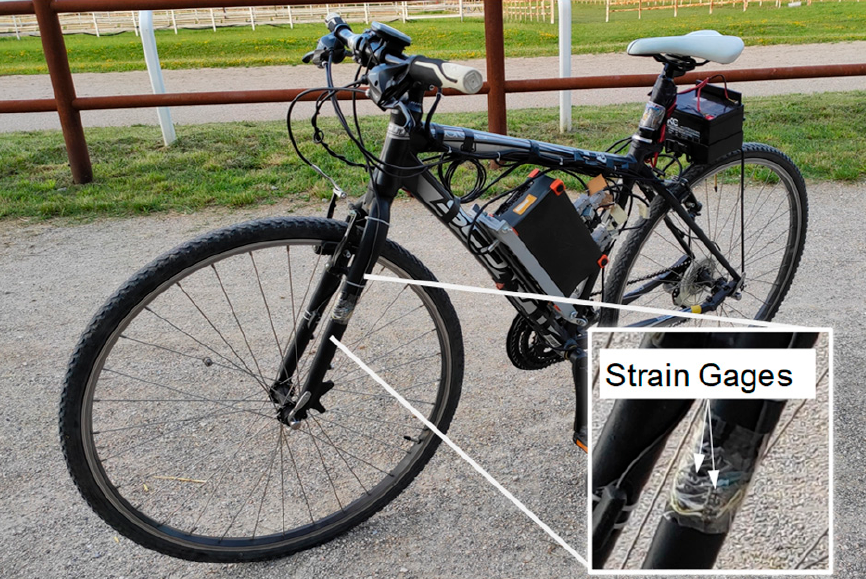
Figure 6. Instrumented mountain bike used in experiments, with strain gages, data acquisition system, battery and speedometer.